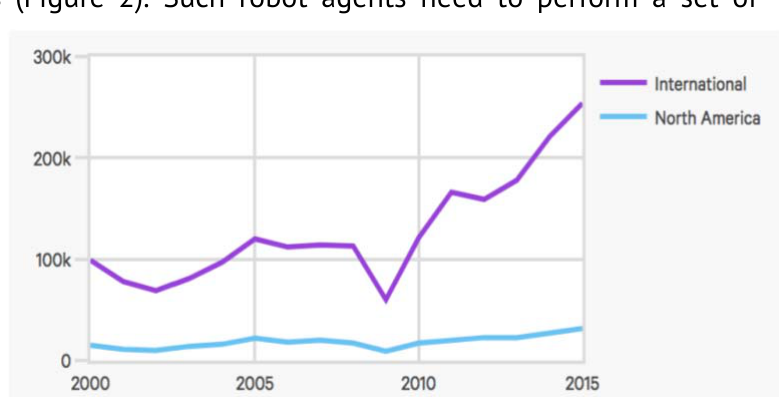
Figure 2 Import of industrial robots units, into North America and globally, between 2000 and 2015 (after